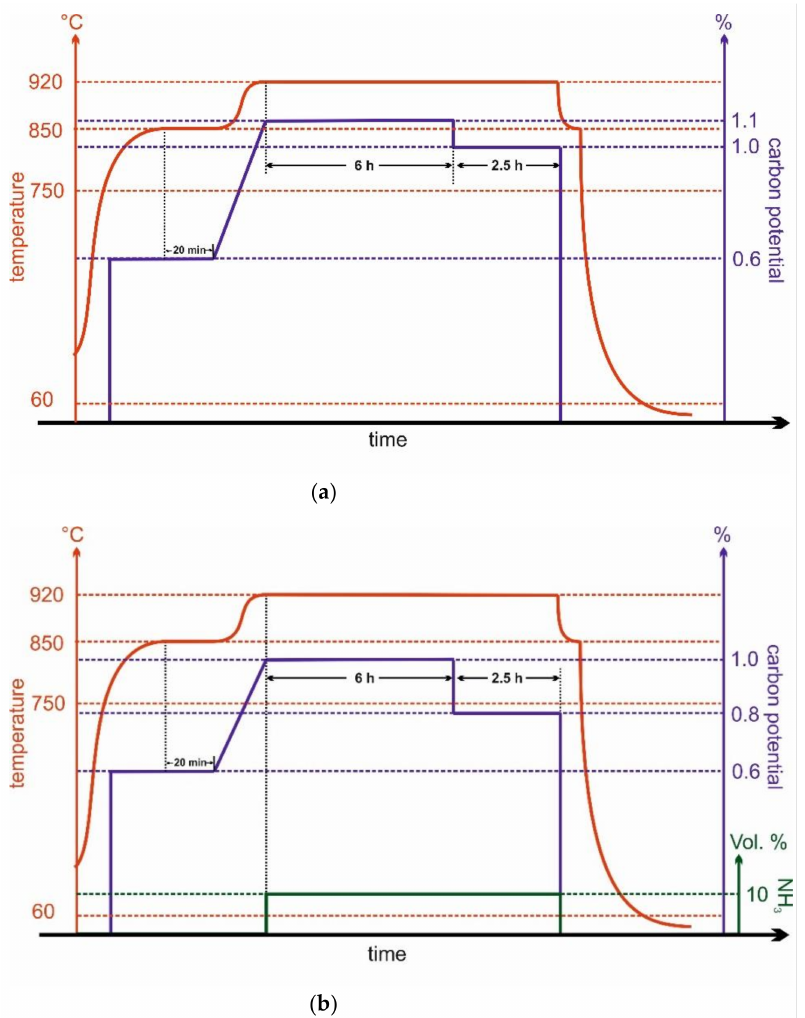
Figure 1. ( a ) Schematic T-t-C-level-course of the carburizing during the case hardening process, and ( b ) the parameters of the carbonitriding